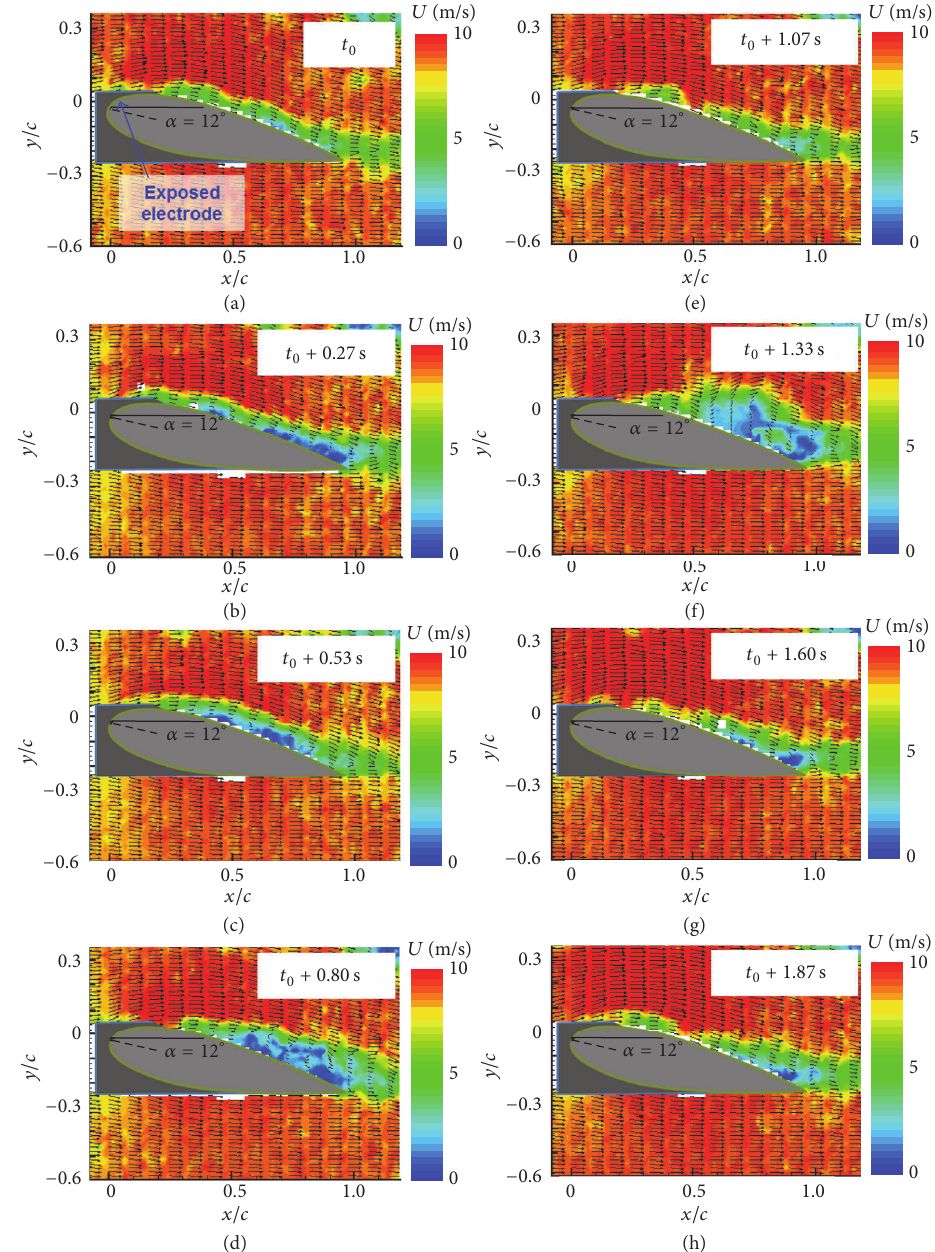
Figure 15: A series of instantaneous velocity distributions ( 1/3.75 ≈ 0.27 s intervals) measured by PIV, with periodic wall oscillation under PA-ON conditions. Flow separation was mitigated by 70% using this closed-loop control